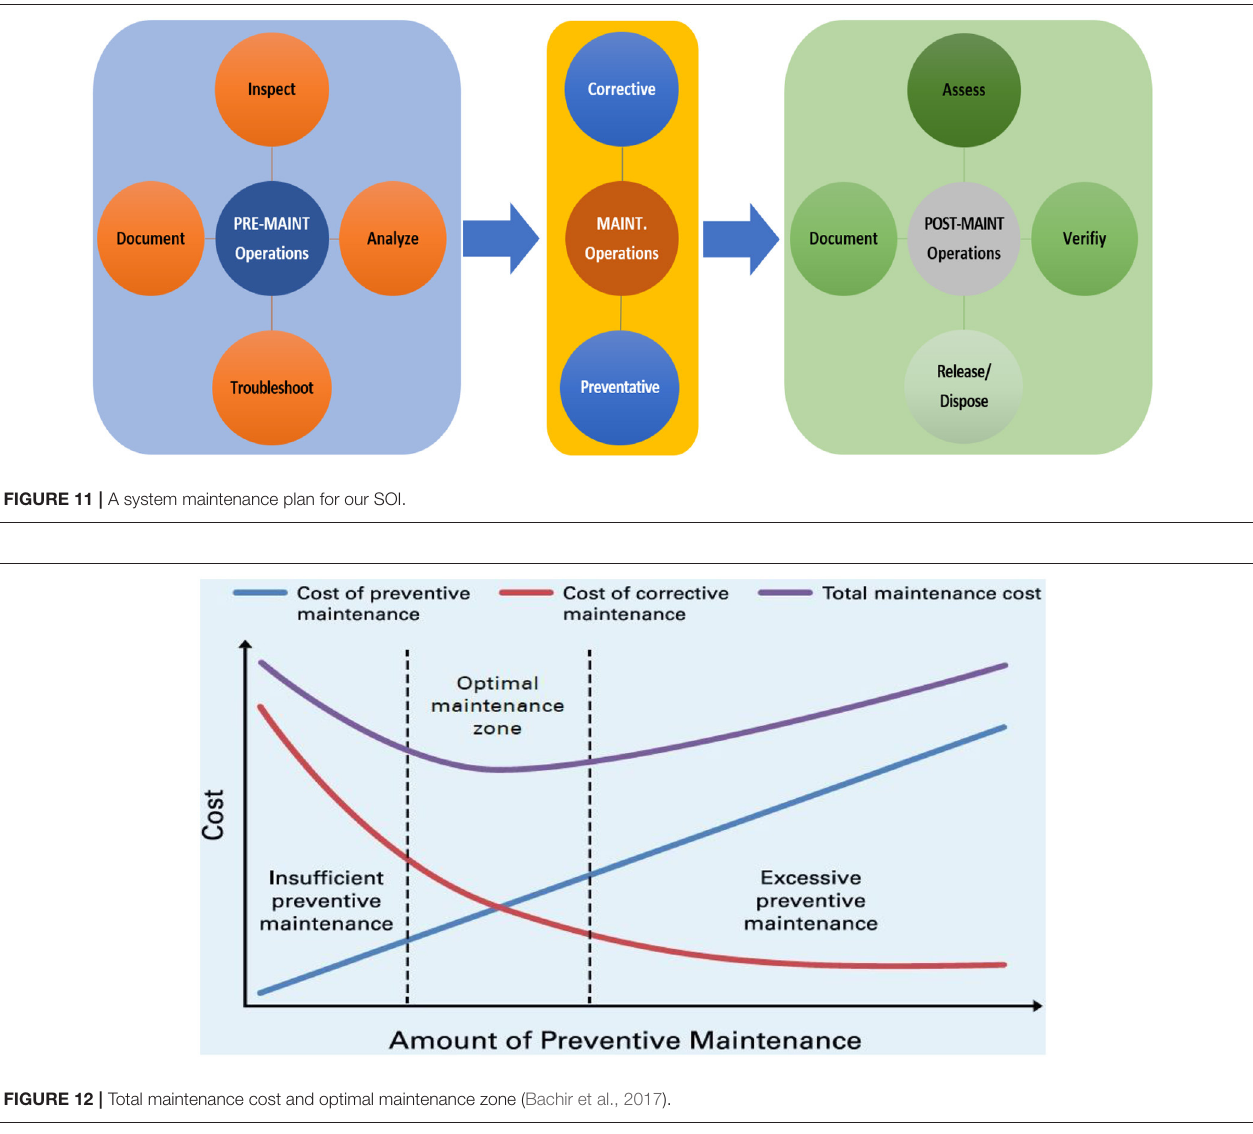
Figure 13 . For our system, the privative maintenance would be performed in case of any problem occurred in SOI or its platform environment, such